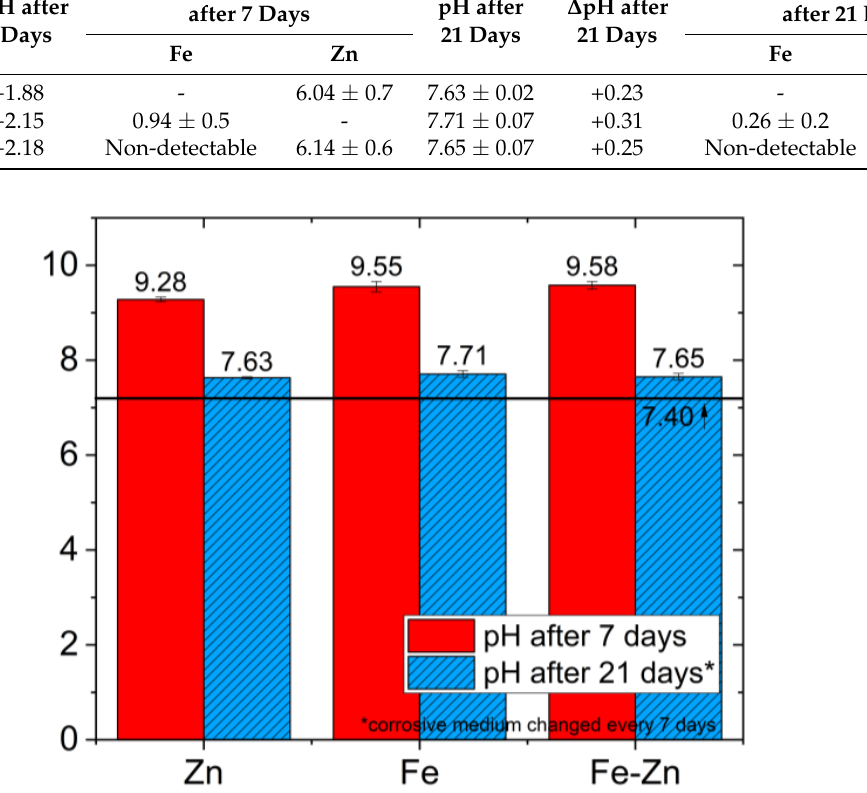
Figure 7. Comparison of changes in pH after 7 and 21 days of immersion in simulated body fluids for Zn, Fe and Fe-Zn compressed powders samples.